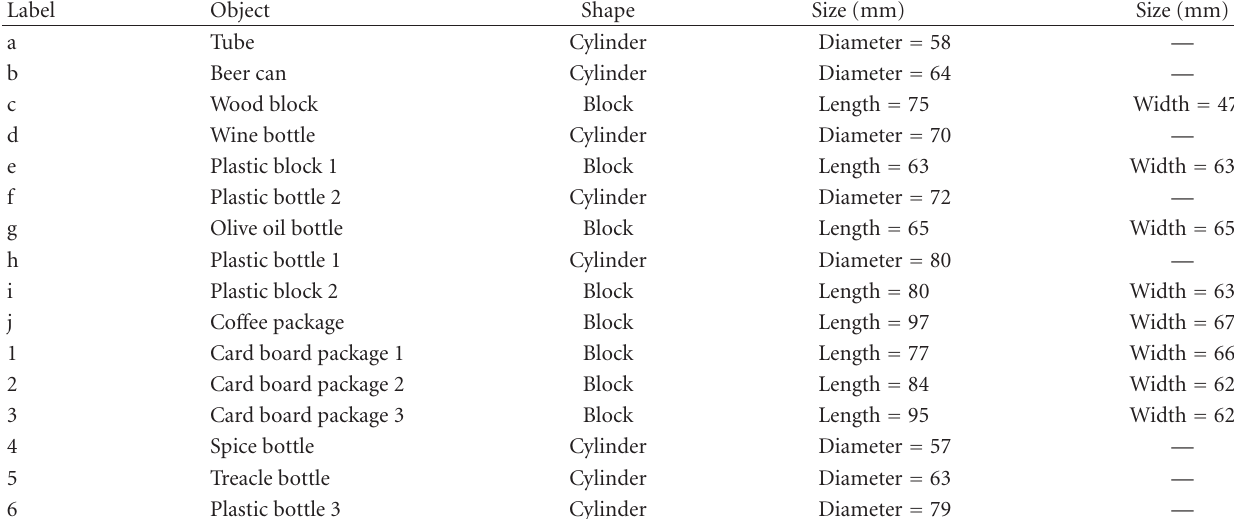
Table 1: The 16 objects used in the experiments with the four systems. The objects a–j were used both for training and testing, whereas the objects 1–6 were used in the generalization